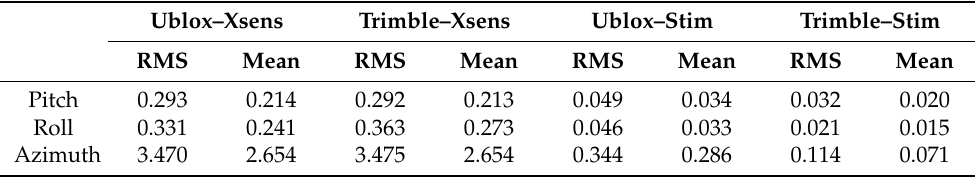
Table 4. RMS error and mean error (deg) of roll, pitch, and azimuth angles—first field trial.